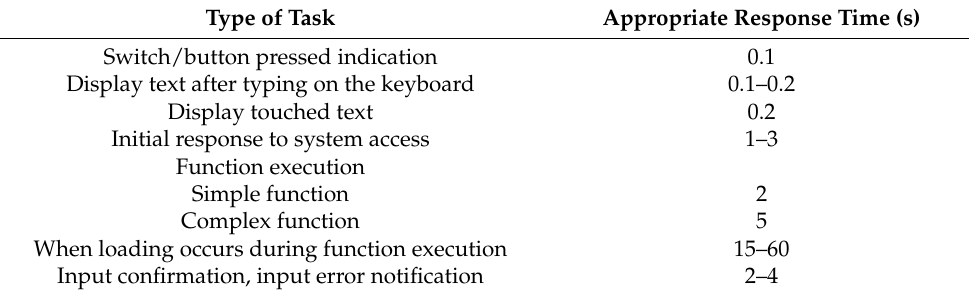
Table 4. Acceptable System Response Times on